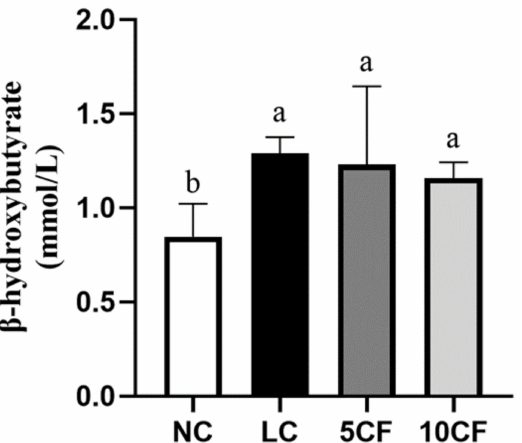
Figure 4. The plasma levels of β -hydroxybutyrate in rats fed with different experimental diets for 11 weeks. Results are expressed as mean ± SD for each group ( n = 8). Mean values with different letters are significantly different, p < 0.05.